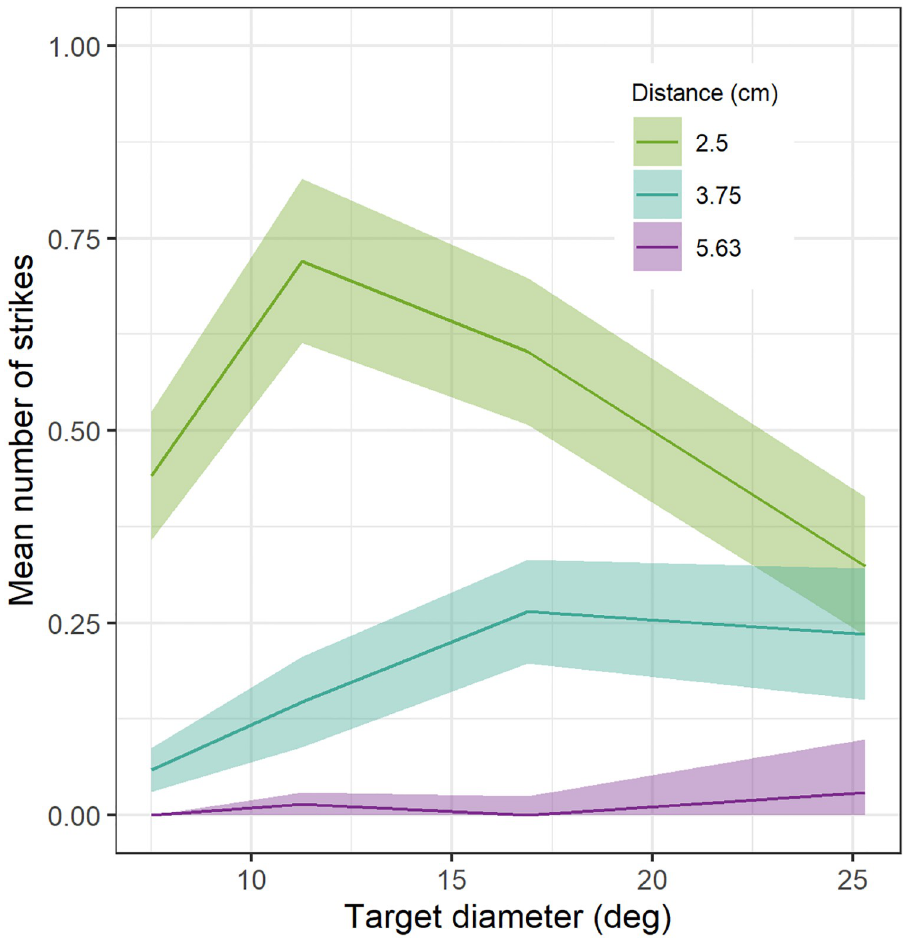
Fig 9. Modified behavioural response of mantids. Mean number of strikes [10] in response to different simulated distances, as a function of the angular size of the simulated target in the crossed condition, with strikes in the corresponding uncrossed condition subtracted. Ribbons show ± 1 standard error on the